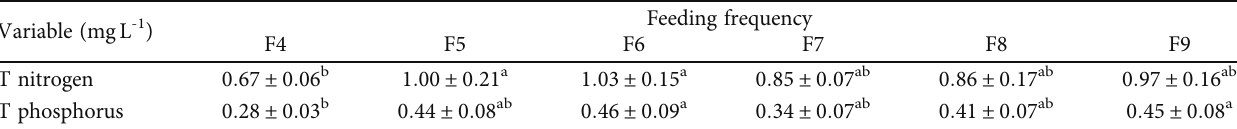
∗ Values without letters or with the same letters, which are on the same line, indicate that there was no signi fi cant di ff erence ( p > 0 : 05 ), whereas those with di ff erent letters indicate a signi fi cant di ff erence ( p < 0 : 05 ). F4: Fed 4 times a day; F5: fed 5 times a day; F6: fed 6 times a day; F7: fed 7 times a day; F8: fed 8 times a day; F9: fed 9 times a day. Table 4: Mean values ± standard deviation of individual weight gain (EG), feed intake (FI), apparent feed conversion (AFC), fi nal biomass (FB), total length (TL), standard length (SL), and hepatosomatic relation (HSR) of Nile tilapia fi ngerlings ( Oreochromis niloticus ) in di ff erent treatments.